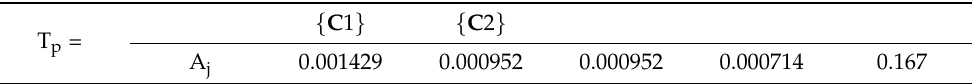
Table 3. The Theoretical Rating Matrix ( T p ) where weight factors for each possible combination between the evaluation criteria were defined using the mathematical expression in Section 4.2.